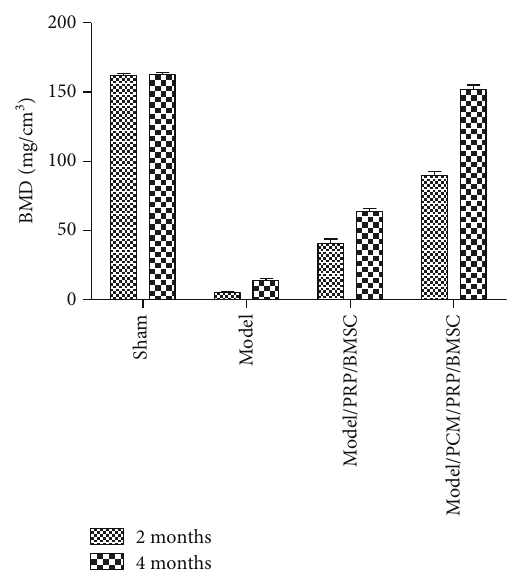
Figure 5: PCM/PRP/BMSC composites increase bone mineral density in rat tibia defect.